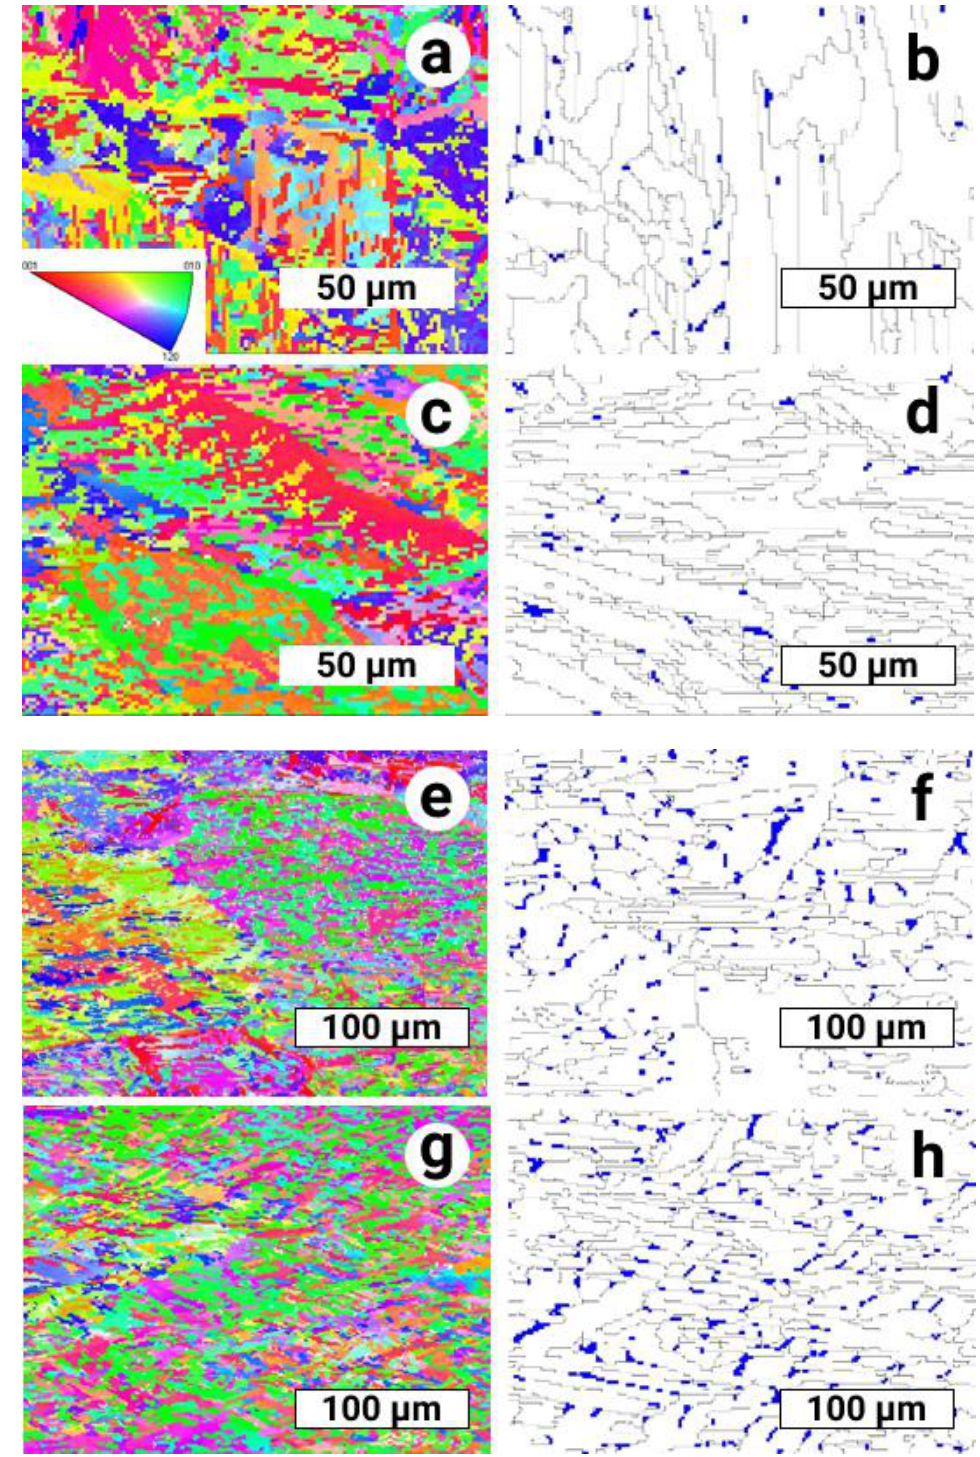
Figure 4. Microstructure of the alloy after EBM and HIP in the form of orientation maps (EBSD): Left column—of α-phase maps in Z-direction with standard color key; Right column—phase map with α-phase (white), interphase and intergranular boundaries (black lines), β-phase is indicated (blue); ( a , b ) S1; ( c , d ) S2; ( e , f ) S3; ( g , h ) S4.